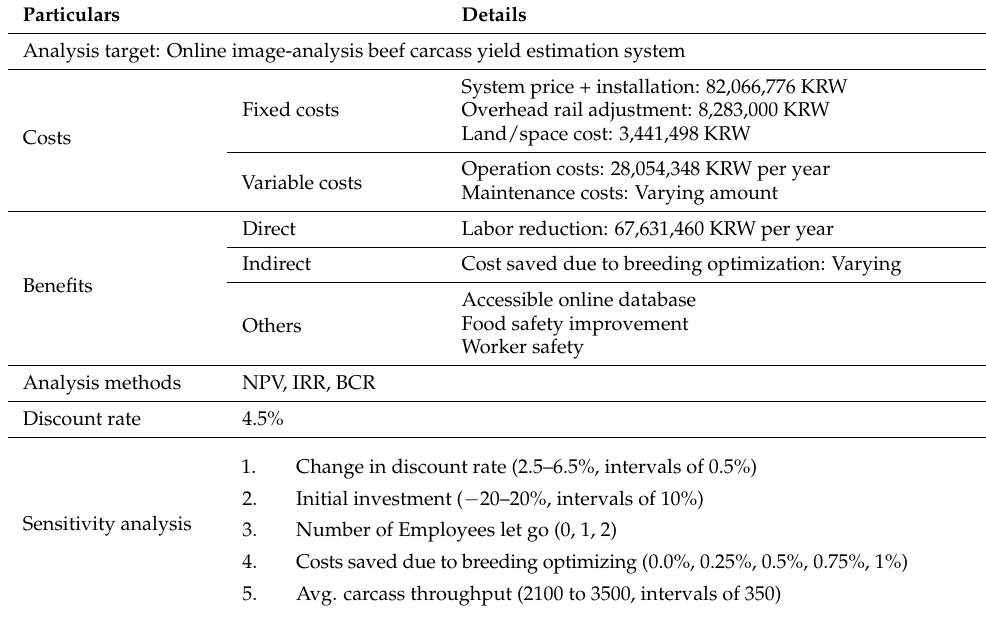
Table 3. A summary of the CBA of the project.